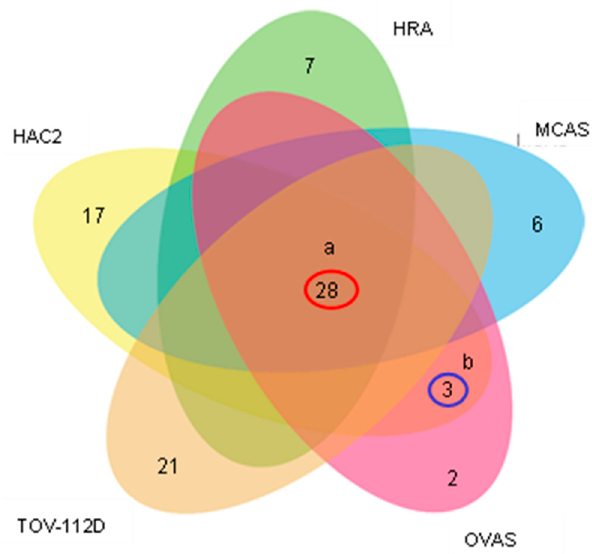
Figure 4. Upregulation of exosomal miRNAs in cell lines representing different histological ovarian cancer subtypes compared to normal cells. The Venn diagram was constructed based on microarray analysis. The numbers of miRNAs overexpressed in each cell type are indicated. The numbers of exosomal miRNAs commonly upregulated in all cell lines compared to control (a) and specifically upregulated in clear cell carcinoma compared to the other histological types (b) are circled red and blue, respectively.